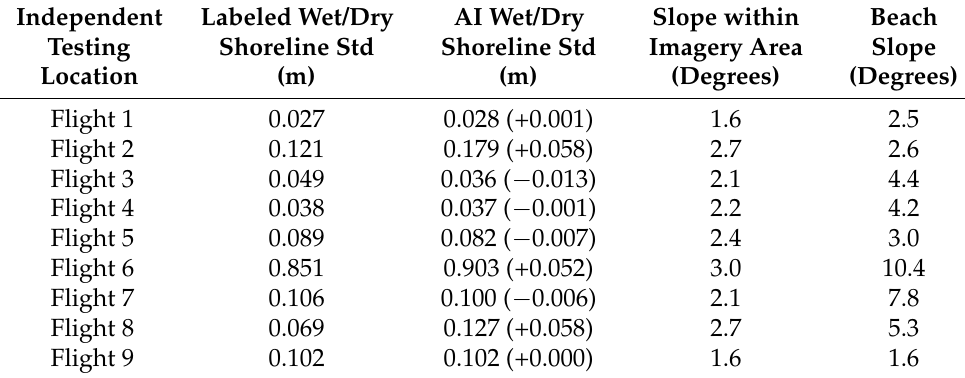
Table 10. Metrics on the Independent Testing